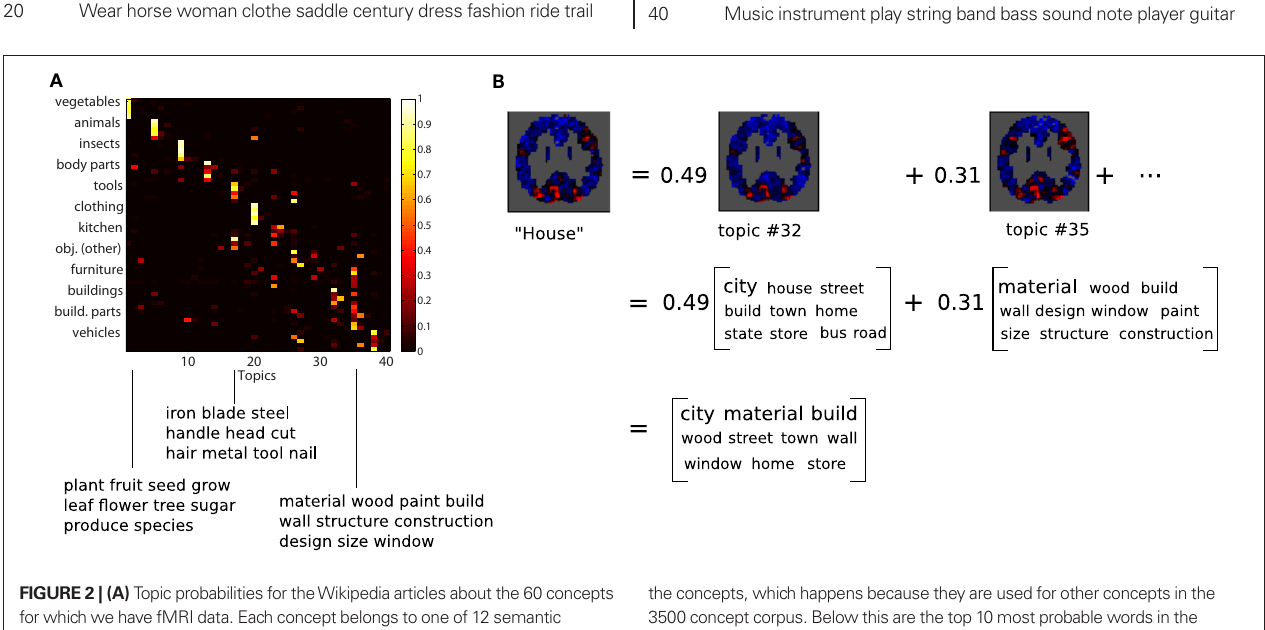
the concepts, which happens because they are used for other concepts in the 3500 concept corpus. Below this are the top 10 most probable words in the probability distributions associated with three of the topics. (B) The decomposition of the brain image for “House” into a weighted combination of topic basis images. The weights allow us to combine the corresponding topic word distributions into an overall word distribution (top 10 words shown).